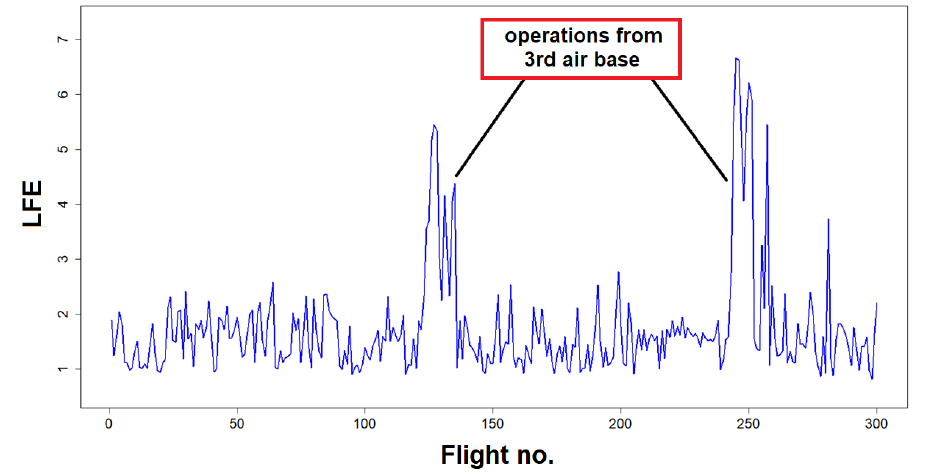
Figure 17. Landing Fatigue Equivalent for subsequent flights of an aircraft in a given